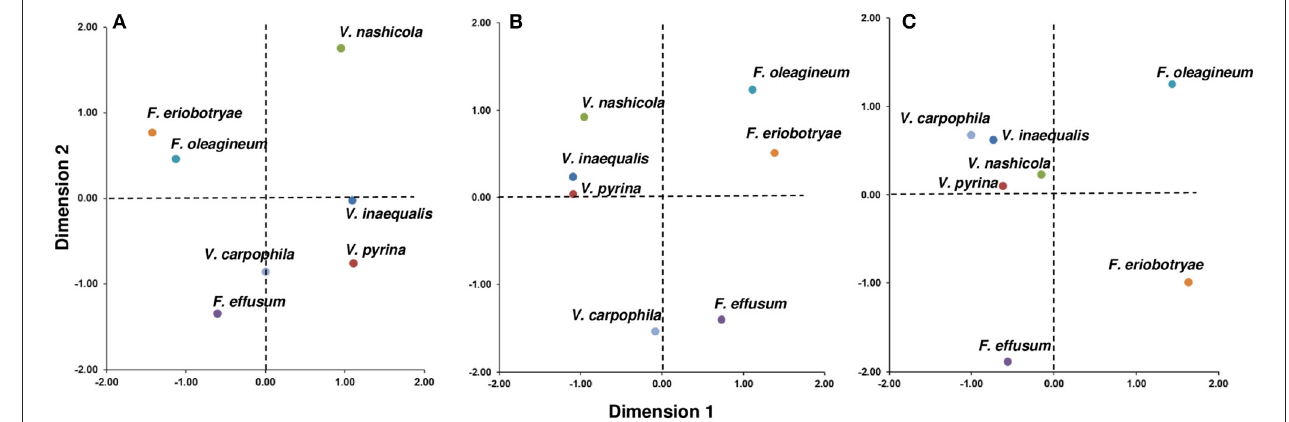
FIGURE 6 | Distribution of seven Venturia spp. based on the environmental requirements of the pathogens and the biological characteristics of the pathogens and their hosts. (A) Joint plot of the correspondence analysis performed with 15 components related to climate and epidemiological variables of the sexual and asexual phase (CA1 in Table 4 ); (B) Joint plot of the correspondence analysis performed with 12 components related to epidemiological variables of the sexual and asexual phase (CA2 in Table 4 ); (C) Joint plot of the correspondence analysis performed with six components related to epidemiological variables of the asexual phase (CA3 in Table 4 ).